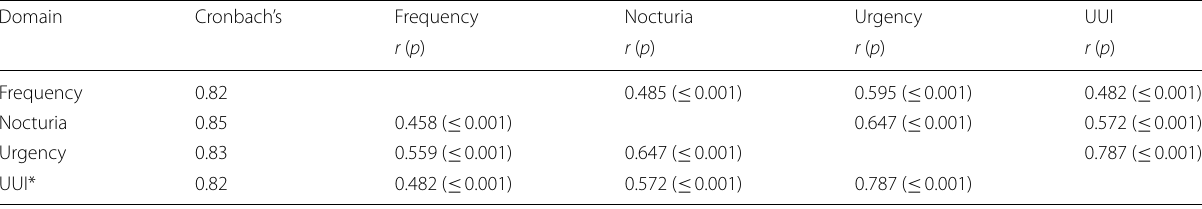
* UUI urge urinary incontinence